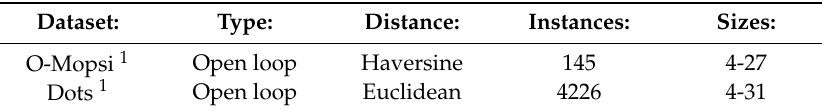
Table 1. Datasets used in this study.